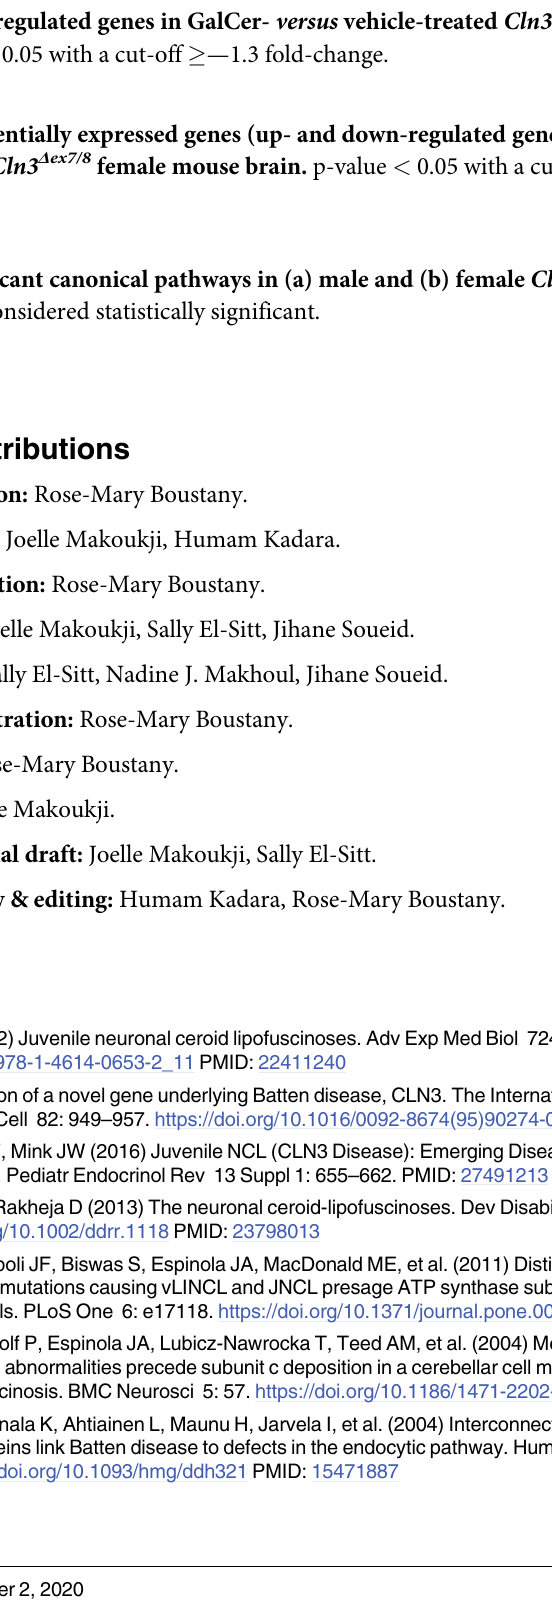
S3 Table. Downregulated genes in GalCer- versus vehicle-treated Cln3 Δ ex7/8 male mouse